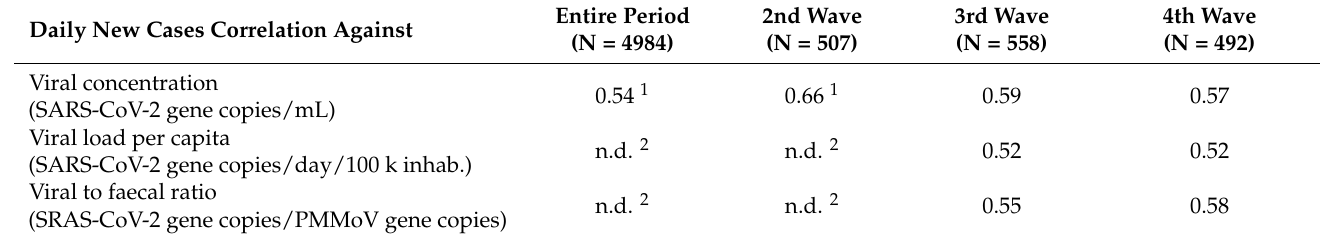
Table 2. Spearman correlation coefficients between the daily new COVID-19 cases and SARS-CoV-2 concentration in wastewater: viral concentrations, viral loads per capita, and viral to faecal ratios.